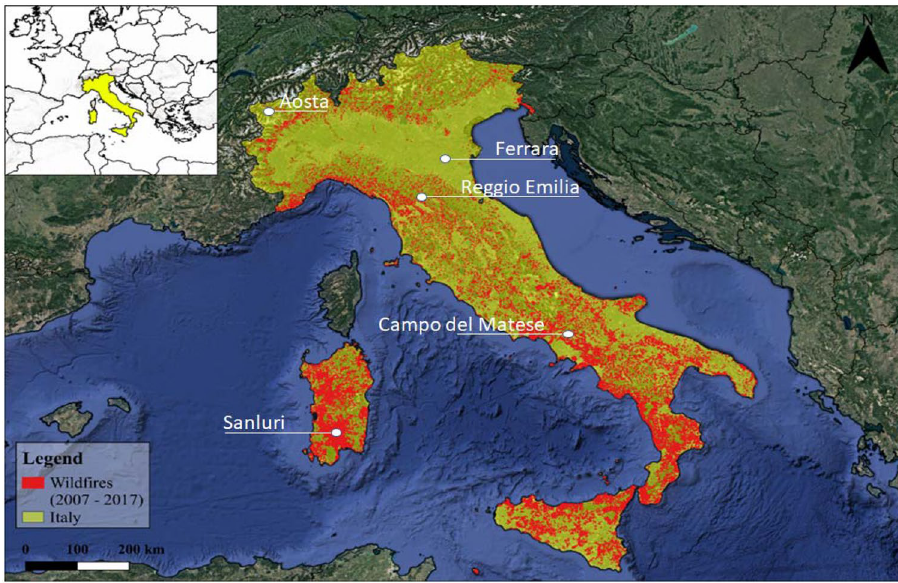
Figure 1. Map of the Italian peninsula (yellow) in the Mediterranean basin illustrating the distribution of wildfire occurrences (red) across the period of investigation. The map was produced on QGIS using the "new layout"